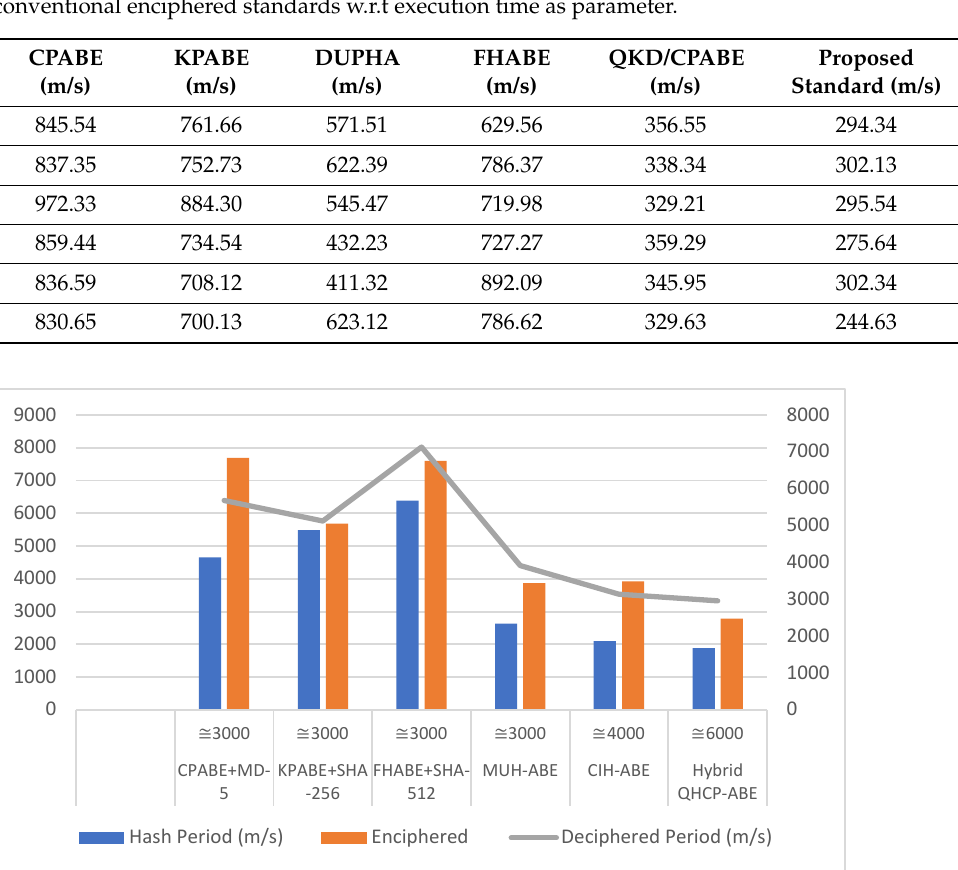
Figure 5. Relative investigational analysis of processing time band of planned standard over the conventional standards on dissimilar datasets. Figure 6 exemplifies the comparative analysis of the memory occupancy efficacy of the proposed standard with respect to conventional ABE standards.